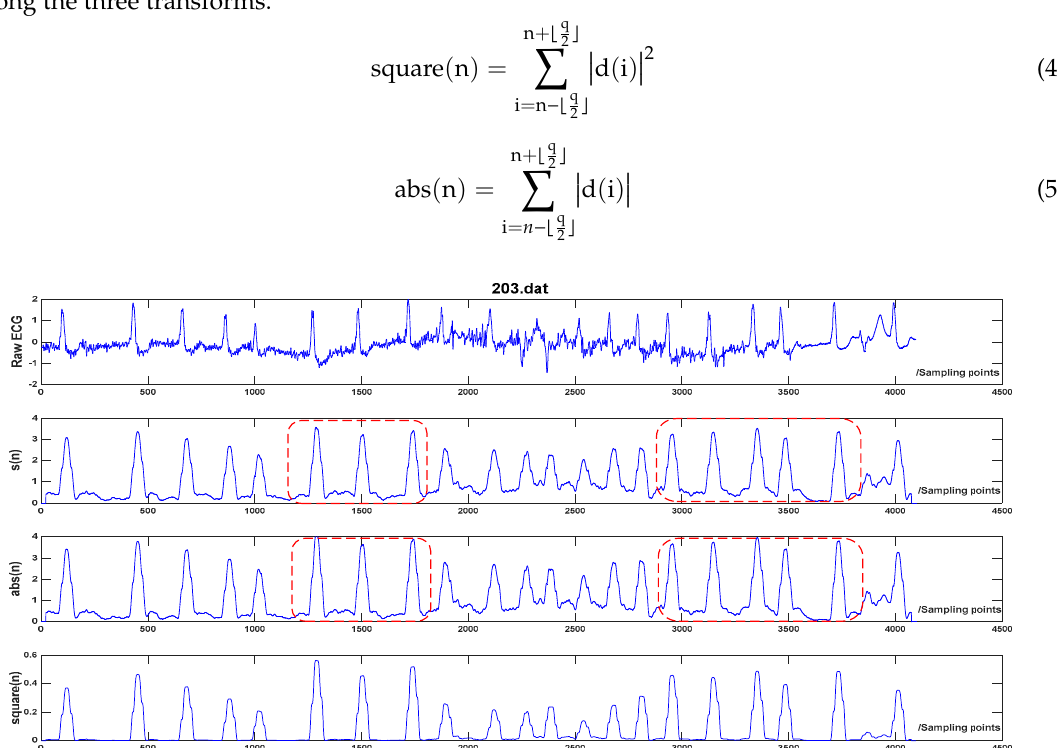
Figure 3. Comparison of three non-linear transforms. The first one is raw ECG of record 203 in the MIT-BIH Arrhythmia Database. The second one to the fourth are the results of using exponential transform, absolute value, and squarer value, respectively. It can be noticed that the amplitude of the signal after ET is compressed compared to the absolute value, especially in the red box. The amplitude deviation after ET is the smallest among the three transforms.